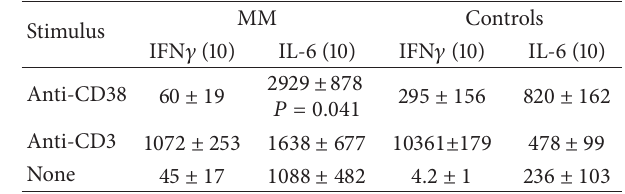
Table 1: Proliferation induced by CD38 ligation is specifically reduced in MM and MGUS patients. a